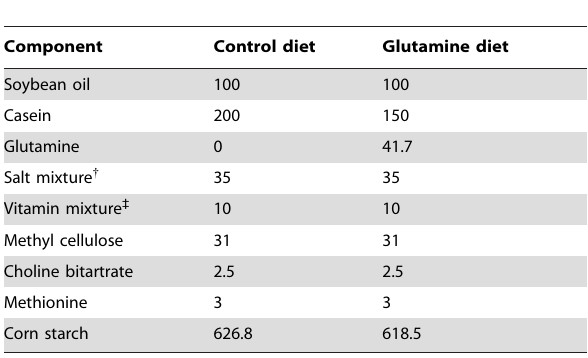
Table 1. Composition of the experimental diets (g/kg).